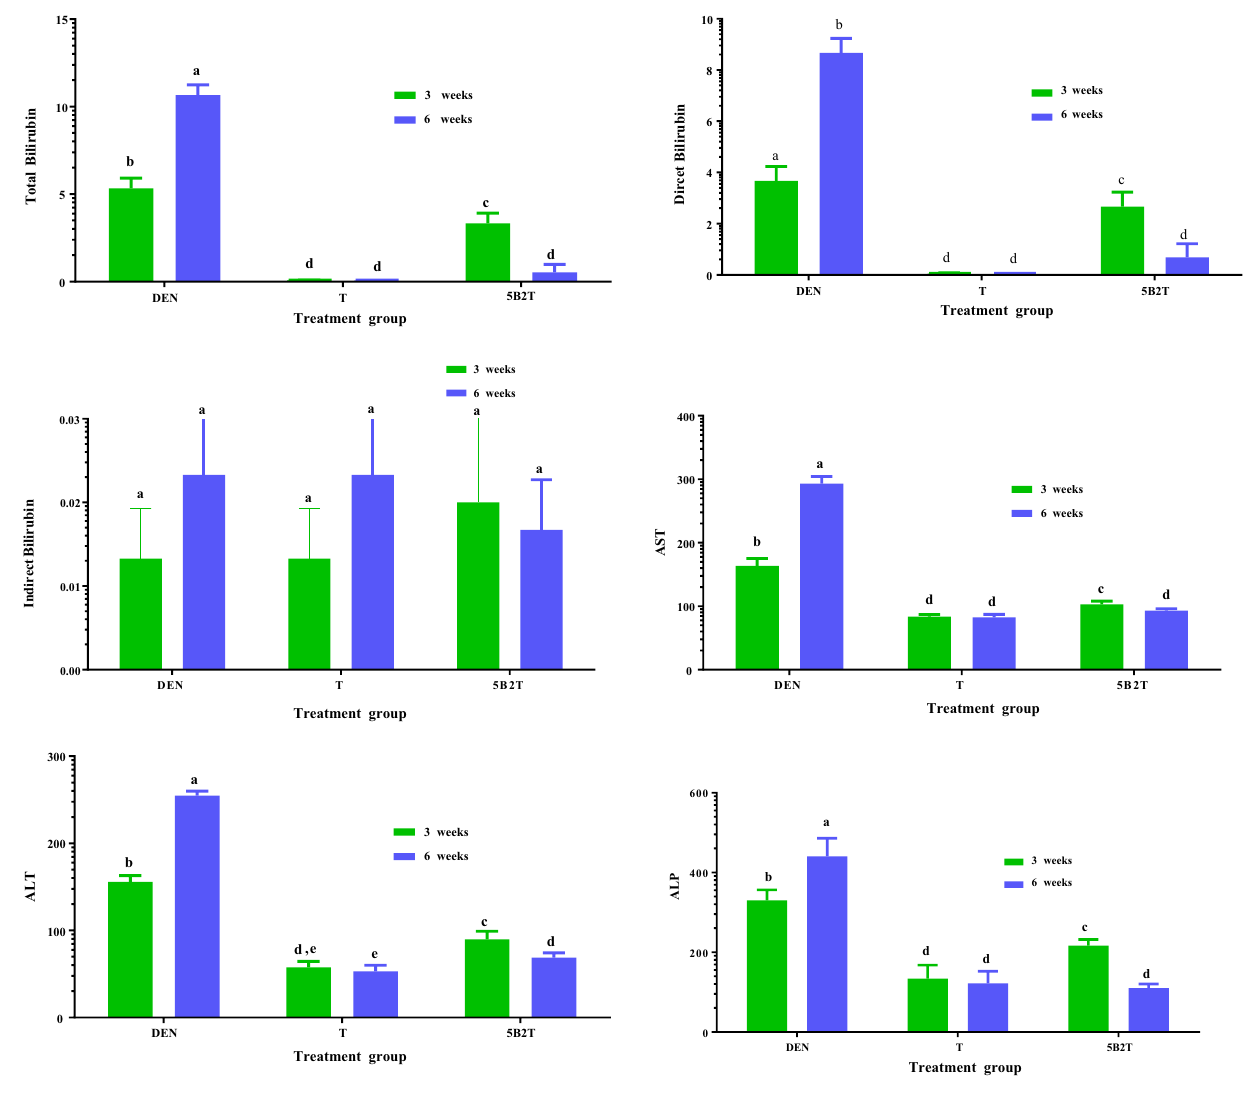
Figure 2. The effect of 5B2T on Liver biochemical parameters. The X axis present the treatment groups and the Y axis presnt the liver function parameters, DEN: diethylnitrosamine, T: 10%tween 80, 5B2T: treatment group. AST: acetate aminotransferase, ALT: alanine aminotransferase, ALP: alkaline phosphatase.